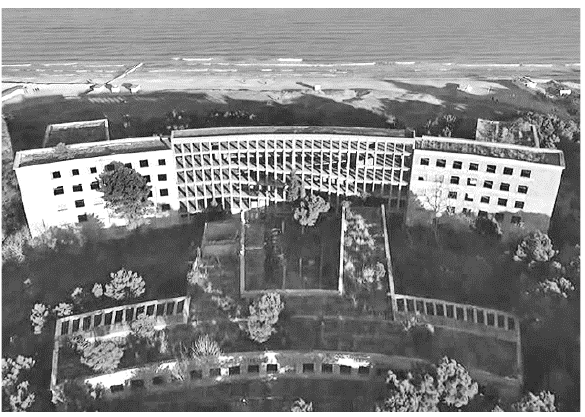
Figure 4 . Varese Colony in 2022.